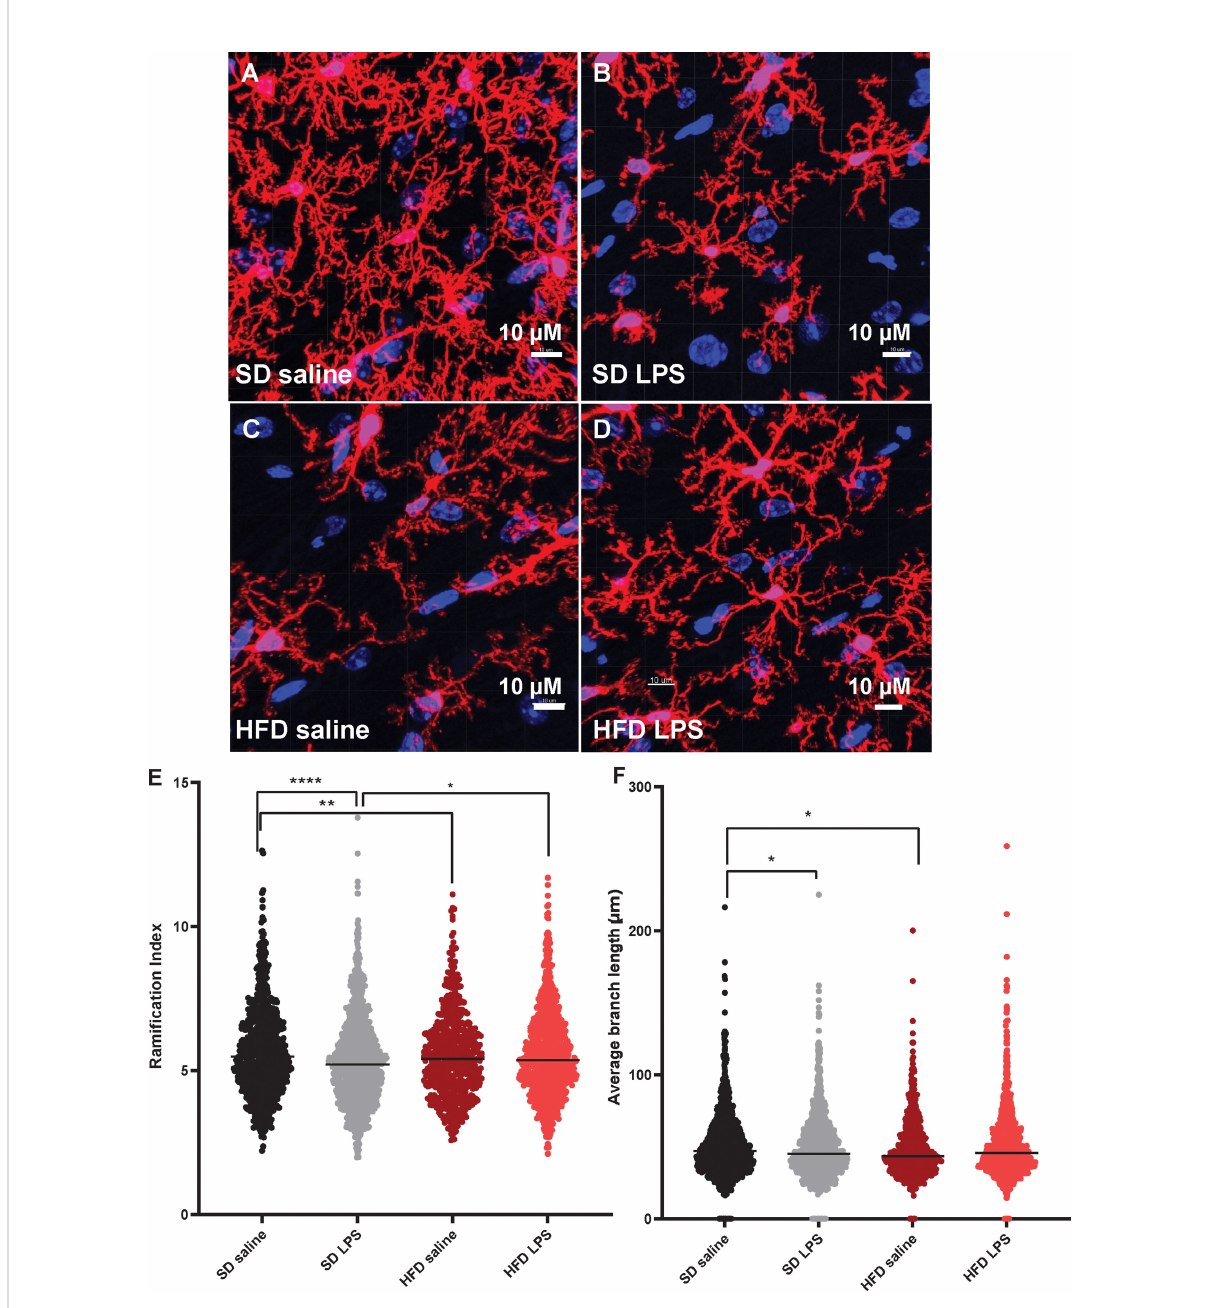
FIGURE 3 Microglial morphology. Representative images of IBA-1 microglia (red stain) in male BL/6 mice fed standard diet (SD) or high fat diet (HFD) who were administered saline or LPS (lipopolysaccharide; A-D ). Quanti fi cation of microglia rami fi cation index (E) and average branch length (F) . In the absence of differences between saline and LPS, data for each dietary group were combined and are presented as SD vs. HFD alone; * p <0.05, ** p <0.01, **** p